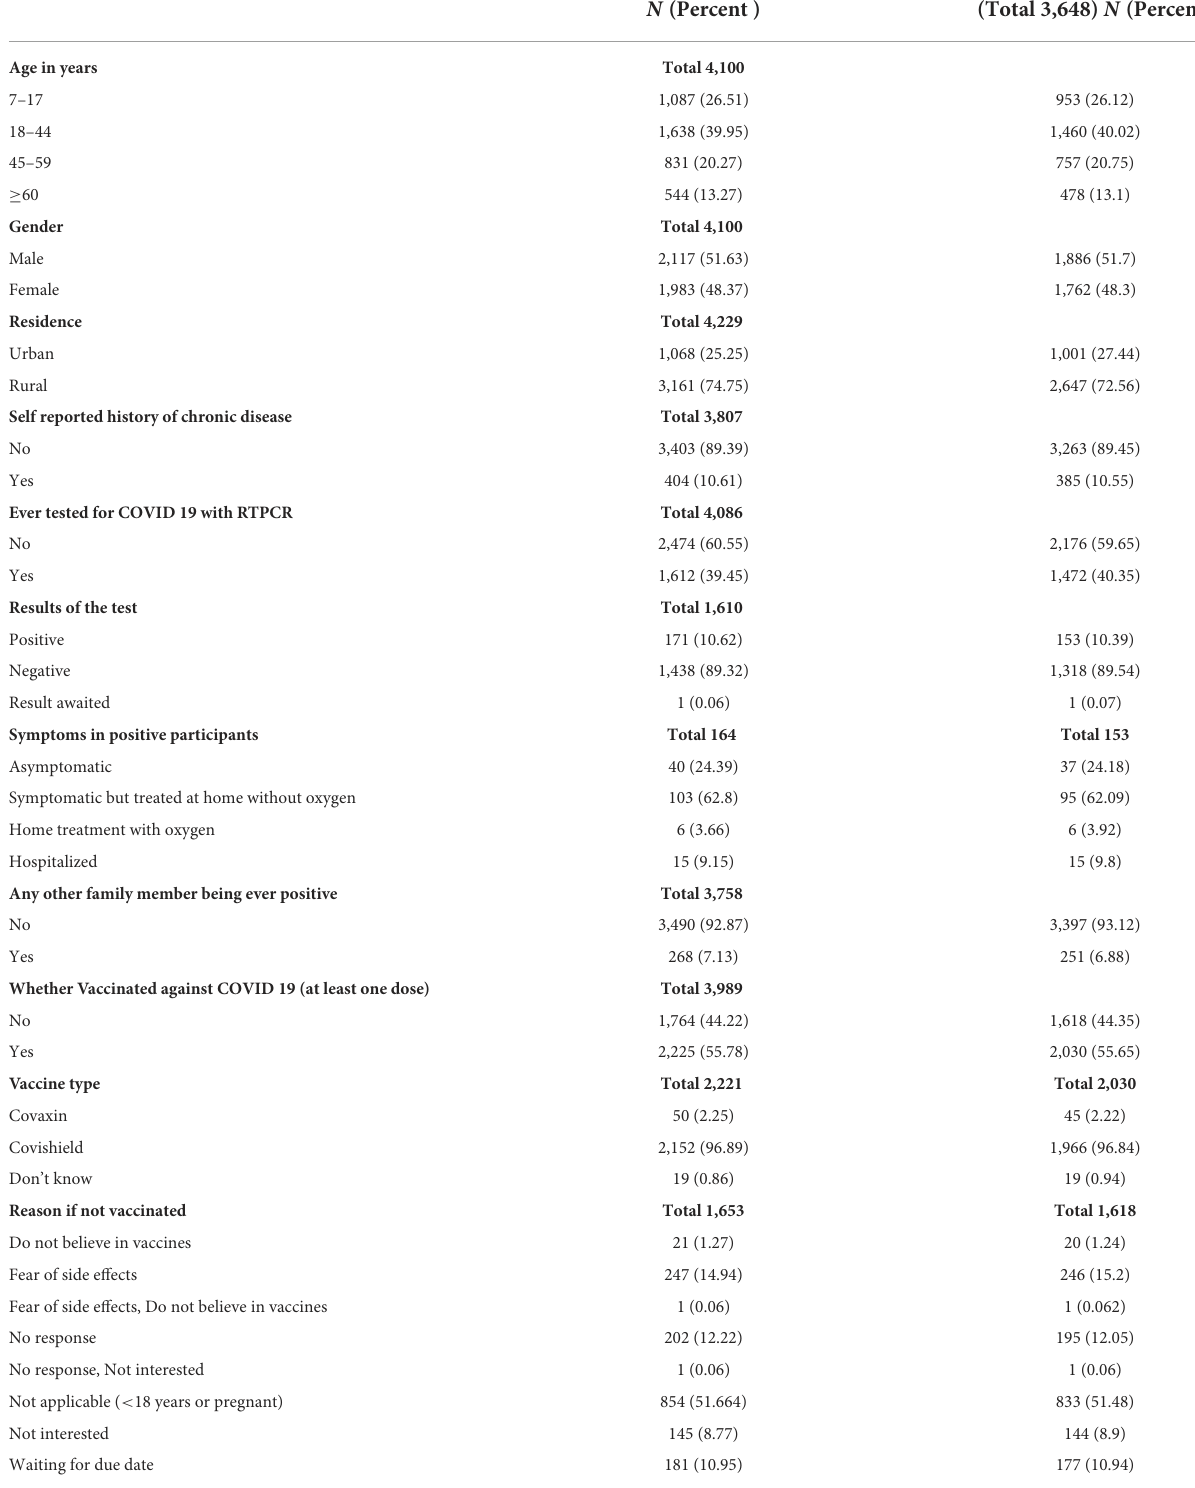
TABLE 1 Baseline characteristics of the study